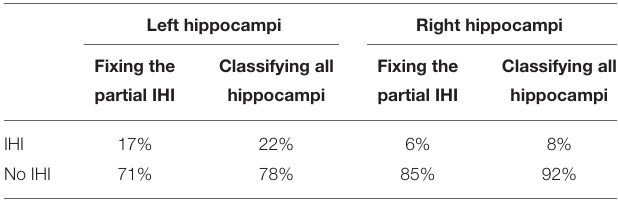
TABLE 9 | Frequency (in % of the whole population for each side) of IHI using the threshold IHI score < 4. Left hippocampi Right hippocampi Fixing the Classifying all Fixing the Classifying